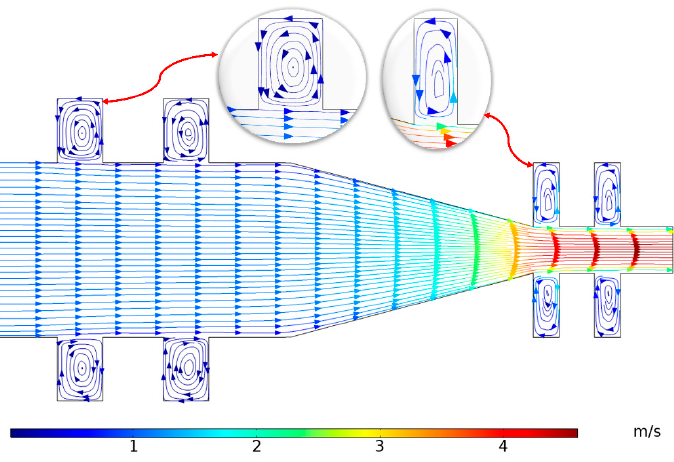
Figure 12. The velocity vector of a BSCN.